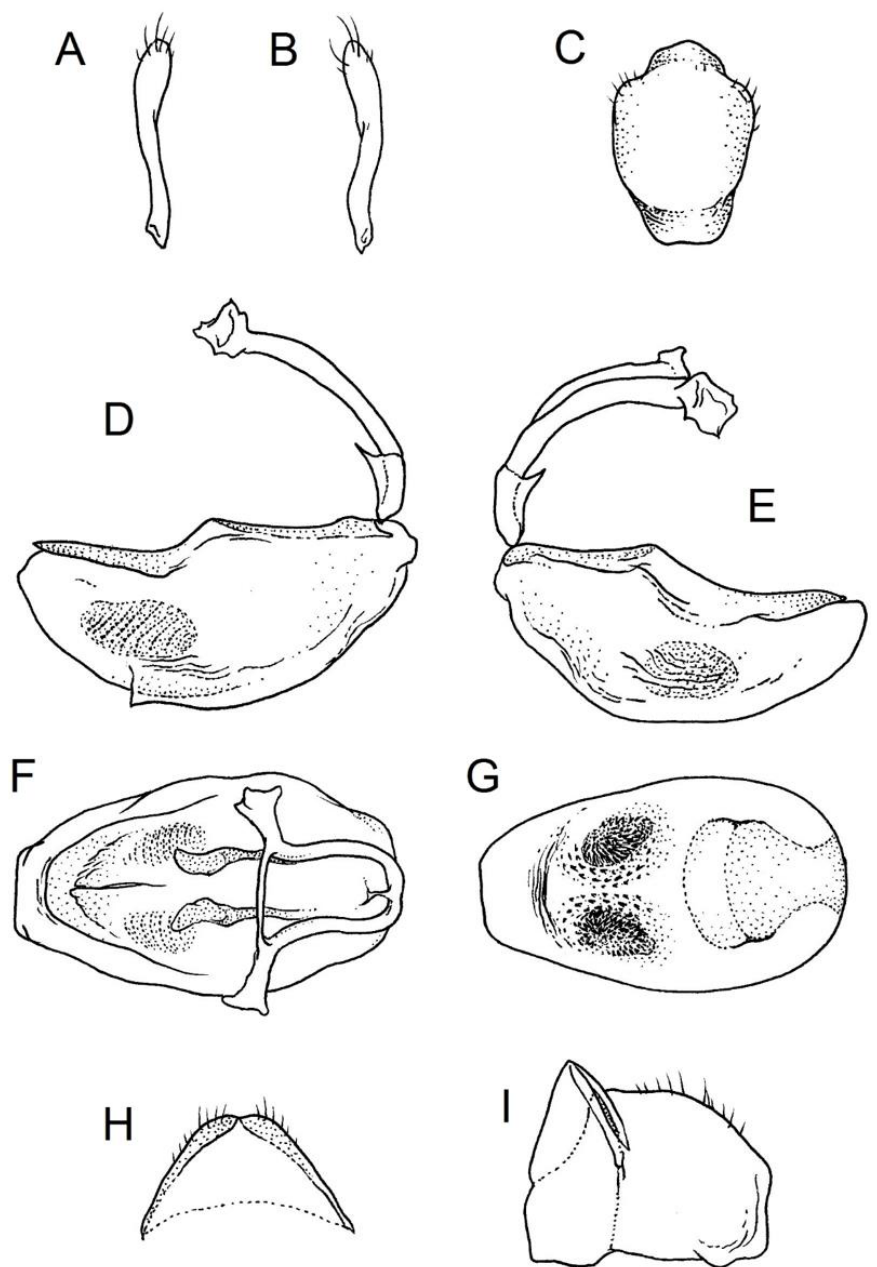
Figure 38. Phonoctonus fairmairei Villiers, 1948: ( A ) left paramere; ( B ) right paramere; ( C ) pygophore, ventral view; ( D ) aedeagus, right lateral view; ( E ) aedeagus, left lateral view; ( F ) aedeagus, dorsal view; ( G ) aedeagus, ventral view; ( H ) styloids, outer view; and ( I ) gonocoxite of abdominal segment VIII. Phonoctonus fasciatus var. fairmairei Villiers, 1948: 9:124. Holotype ( ille;